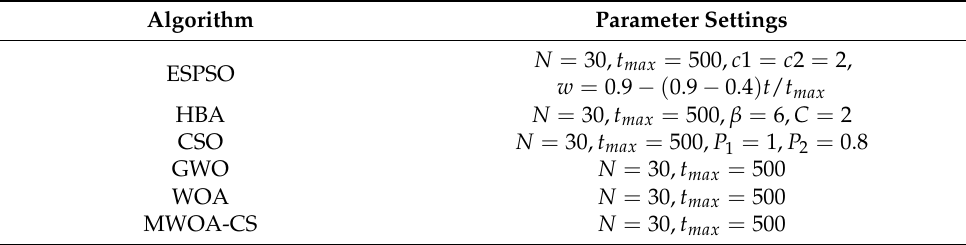
Table 2. Parameter